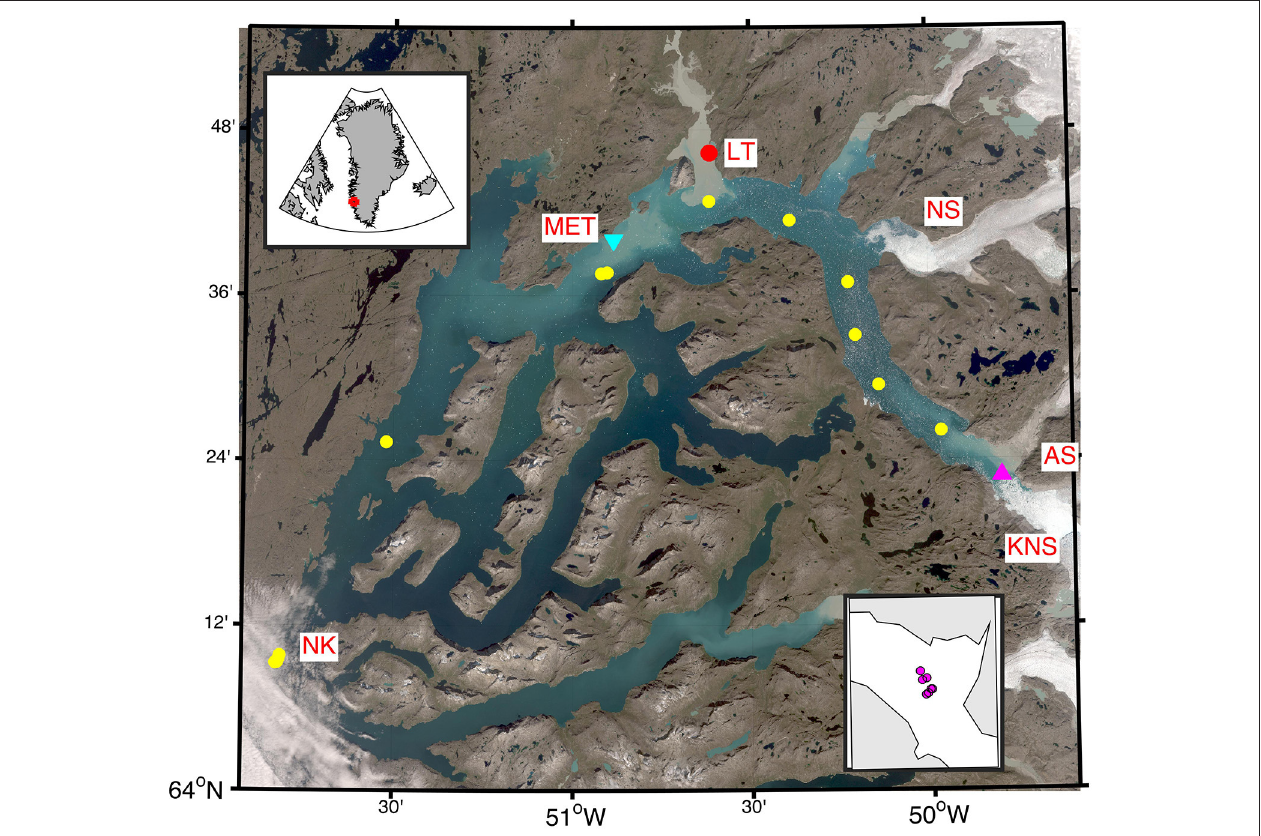
FIGURE 1 | The greater Godthåbsfjord region with the EXITE deployment area near the terminus of the fjord indicated by the pink triangle. The inset at the bottom right shows individual EXITE deployment locations. The inset at the upper left shows the location of Godthåbsfjord (outlined in red) in Greenland. Greenland’s capital city of Nuuk (NK) is located near the mouth of the fjord (lower left). CTD profile locations are indicated by yellow circles, with the first profile coinciding with the EXITE deployment location. The location of the Asiaq Greenland Survey meteorological station (MET) is shown by the light blue triangle. The outflow from Lake Tasersuaq (LT) is indicated by a red circle and the turbid outflow plume is visible. The three tidal-outlet glaciers, Narssap Serbia (NS), Akugdlerssûp Serbia (AS), and Kangiata Nunâta Sermia (KNS), are also